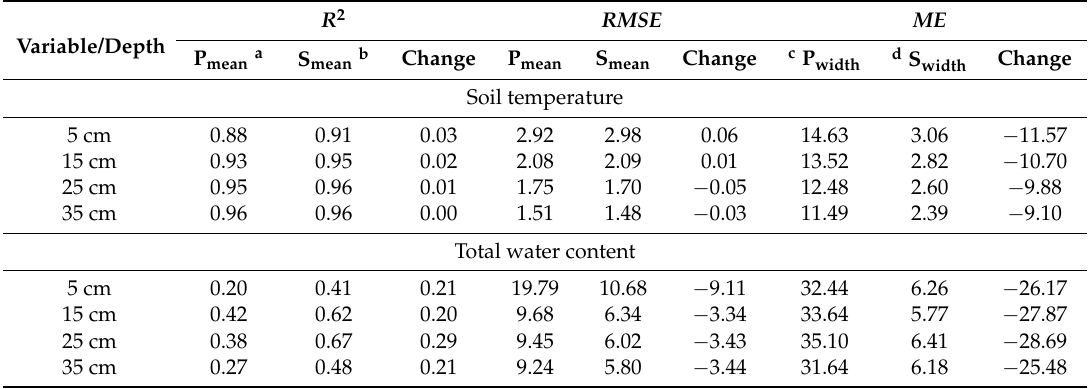
Table 4. Comparison of model performance indices for calibrated